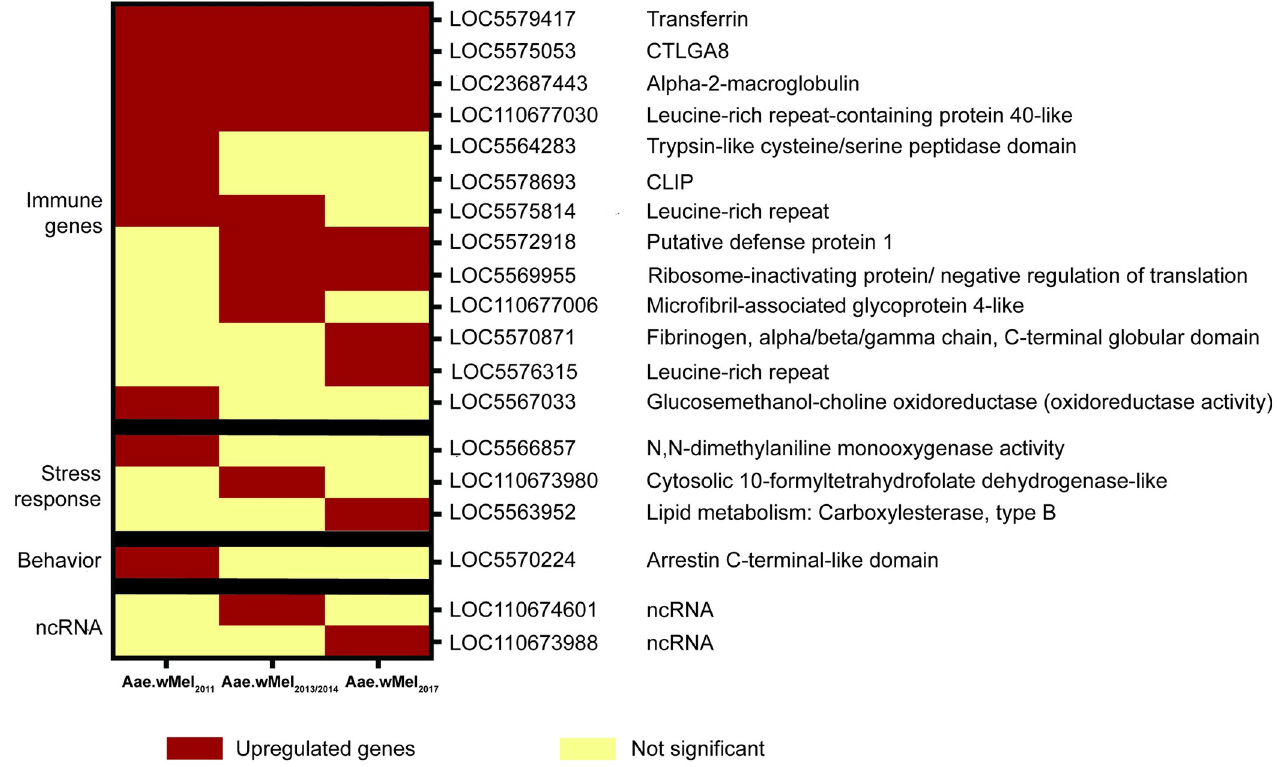
Fig 5. The top 10 upregulated genes with highest fold difference between Wolbachia -infected and uninfected Aedes aegypti , according to release year. The type of upregulated gene (immune genes, stress response, ncRNA, and behaviour) is shown.